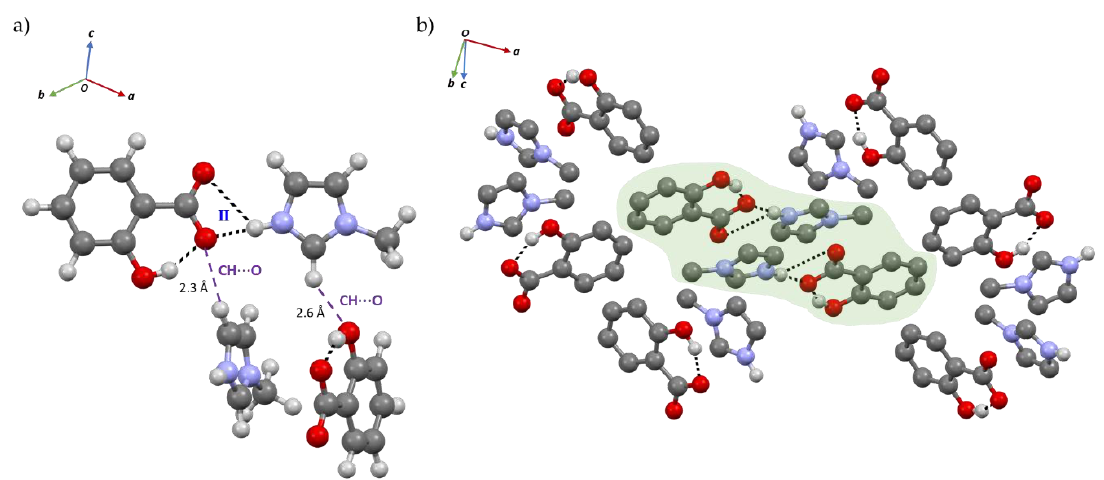
Figure 5. ( a ) Strong N-H (1-MEIM) ··· O (SA) and weak C-H (1-MEIM) ··· O (SA) HB interactions of SA:1-MEIM salt; ( b ) Packing interactions (light green) highlighting the two independent parallel layers. SA aliphatic hydrogen atoms were omitted for clarity.